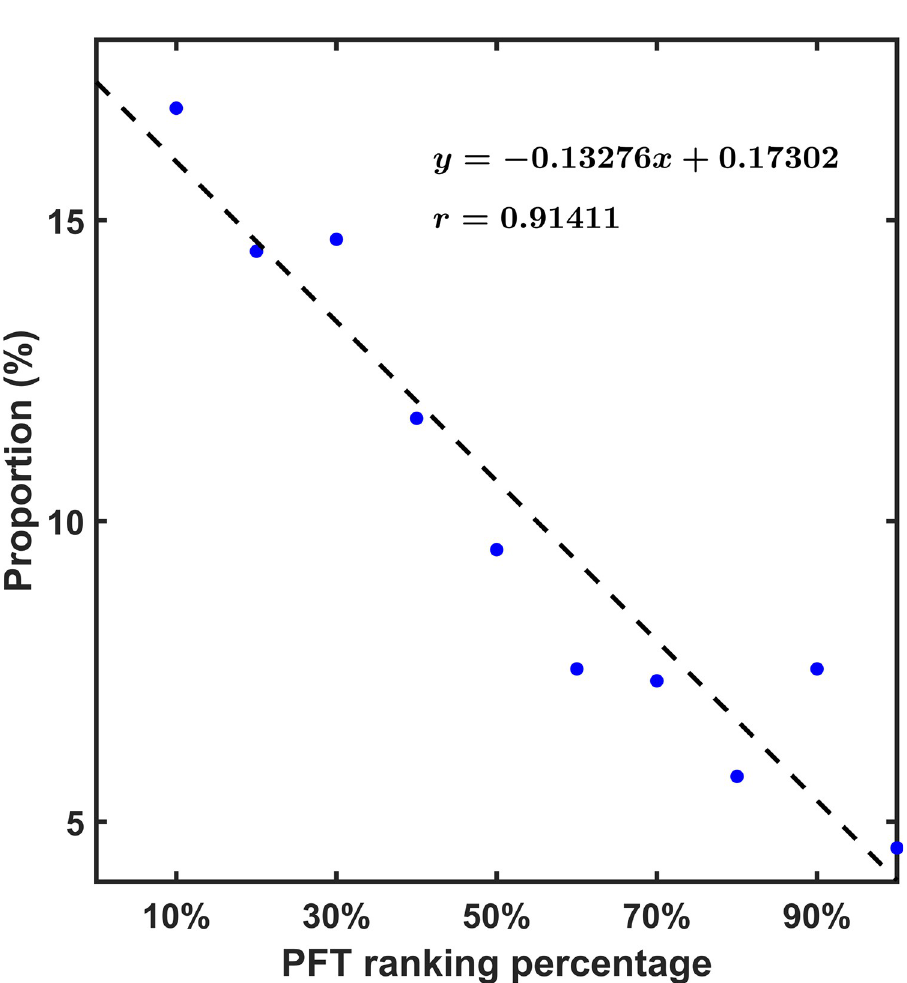
Fig 3. Linear regression of the proportion of athletes in each PFT ranking interval among all the top 8 athletes in four competitions. The regression equation and correlation coefficient are also listed. https://doi.org/10.1371/journal.pone.0267711.g003 each competition, i.e., the sum of the numbers in each row of Table 5 is 16. For example, the number ’4’ in the first row and first column means that in the 8 female’s semifinals of the first competition, 4 of the athletes who ranked first in the PFT won the championship. Clearly, assuming that every athlete who enters the semifinals has an equal chance of winning the first place, the expectation of this value should be 2.